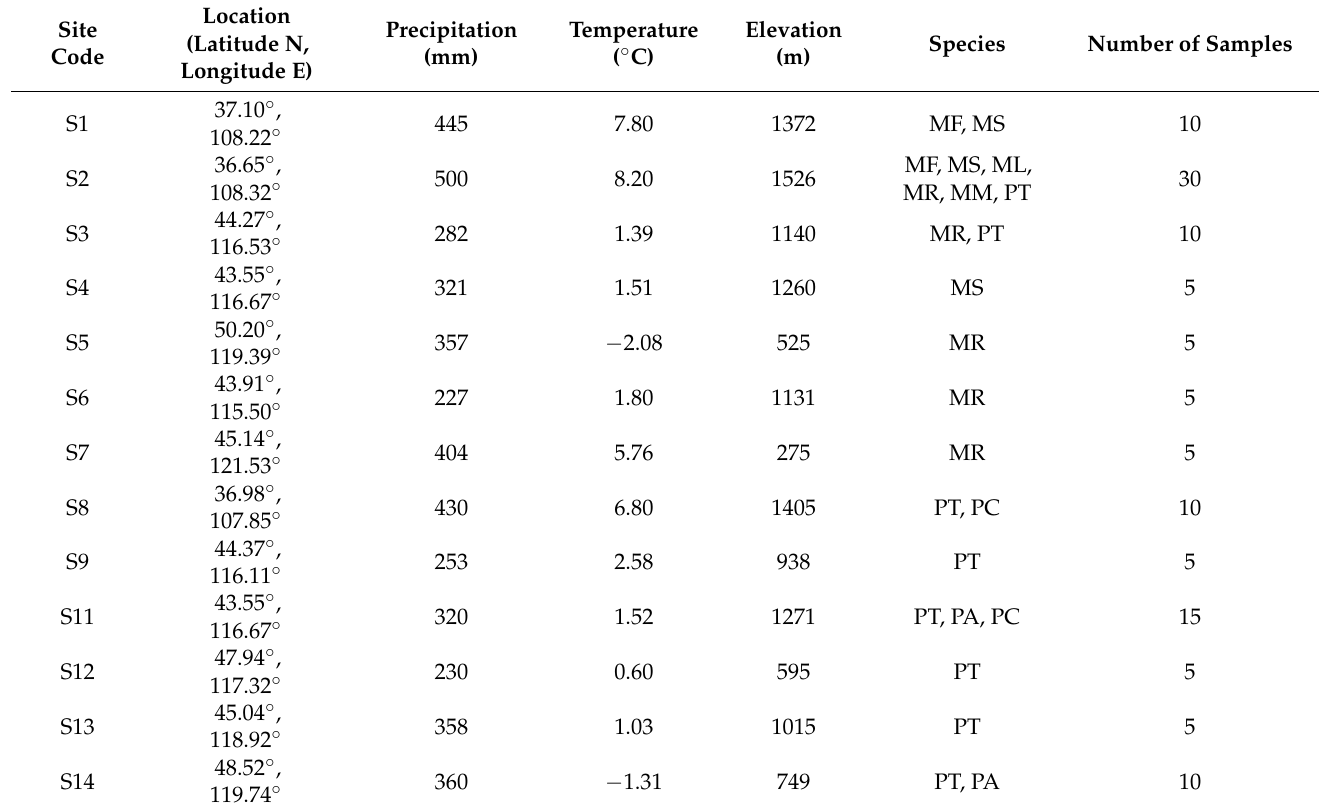
Table 1. Site characteristics of non-native and native herbaceous species in arid and semiarid areas of